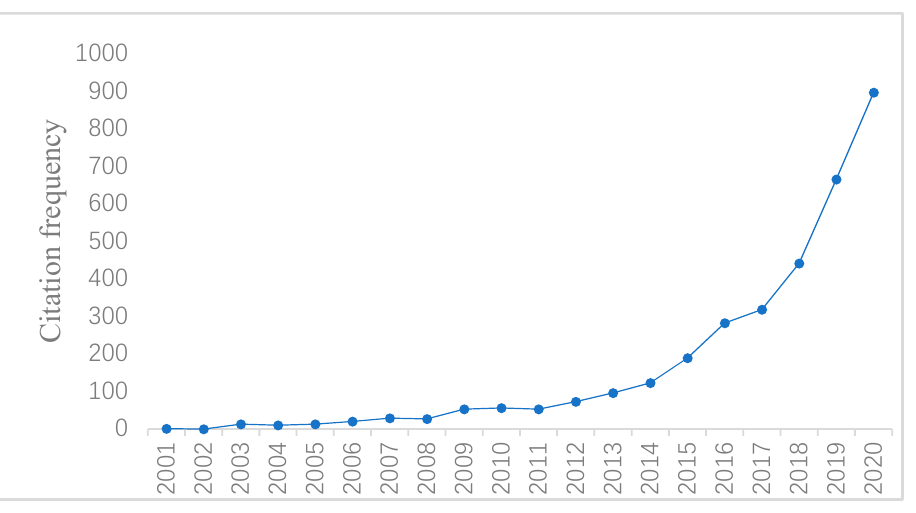
Figure 1. Trends in the citation frequency of the 248 included articles from 2000 to 2020.